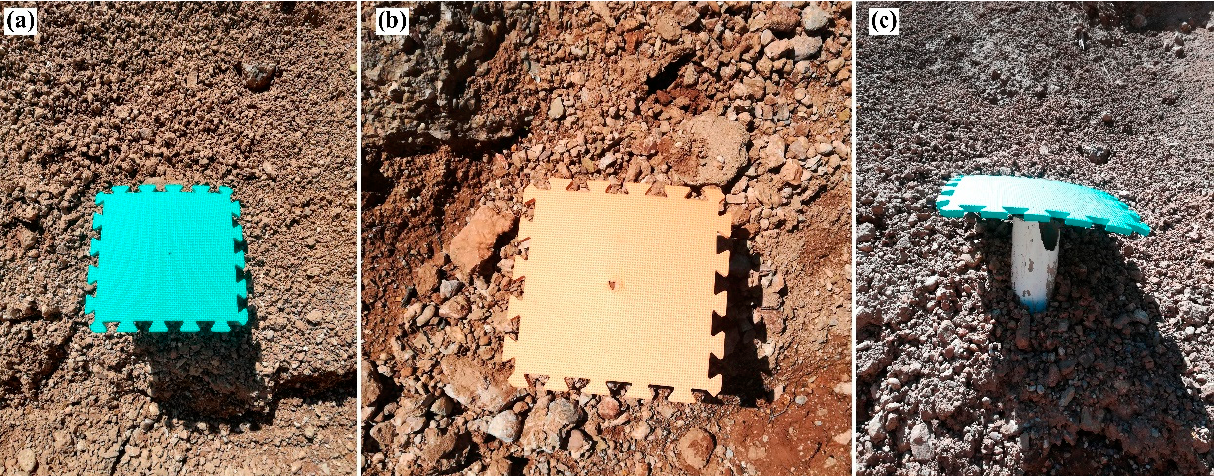
Figure 2. ( a – c ) GCP patterns, located on permanent pillars.